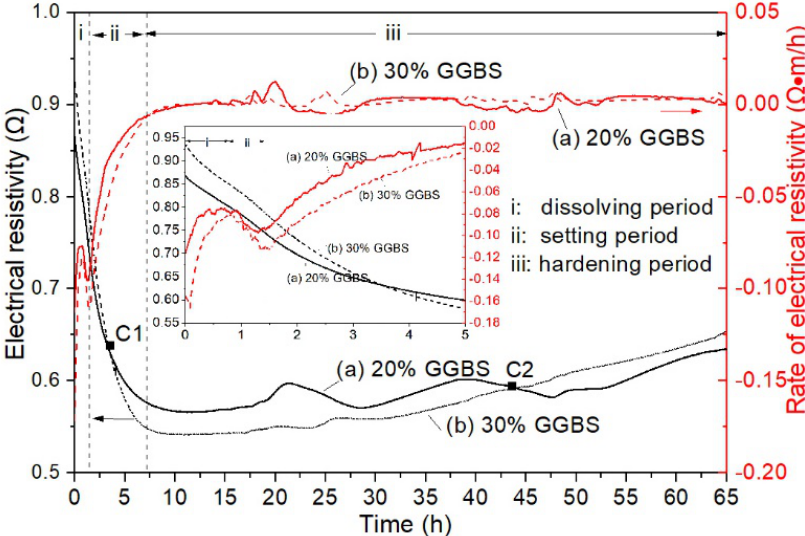
Figure 8. Electrical resistivity of alkali activated LFA-GGBS hybrid binder with different GGBS content (Na 2 O content 10%, n = 1.4, and w/s = 0.4): (a) 20% GGBS; (b) 30% GGBS content.